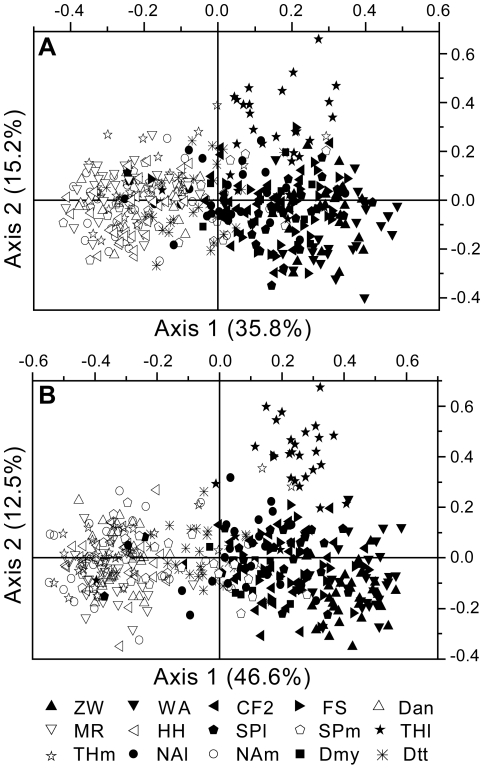
PCo plots of pairwise individual genetic distances Φ at SSR (A) and AFLP (B) markers.Filled symbols: Quercus liaotungensis; open symbols: Q. mongolica; radial symbols: intermediate individuals from population Dtt.